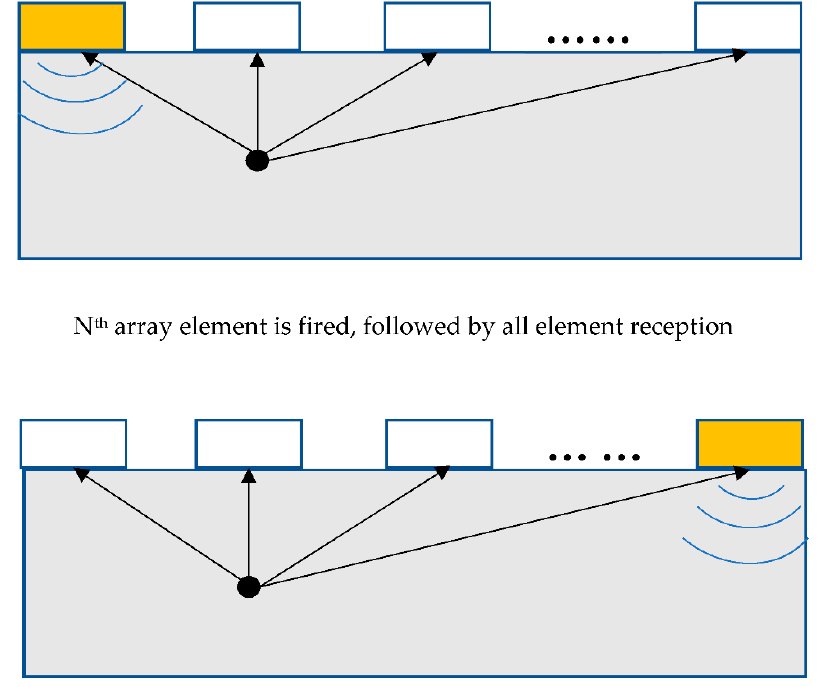
Figure 2. Schematic diagram of FMC data acquisition.